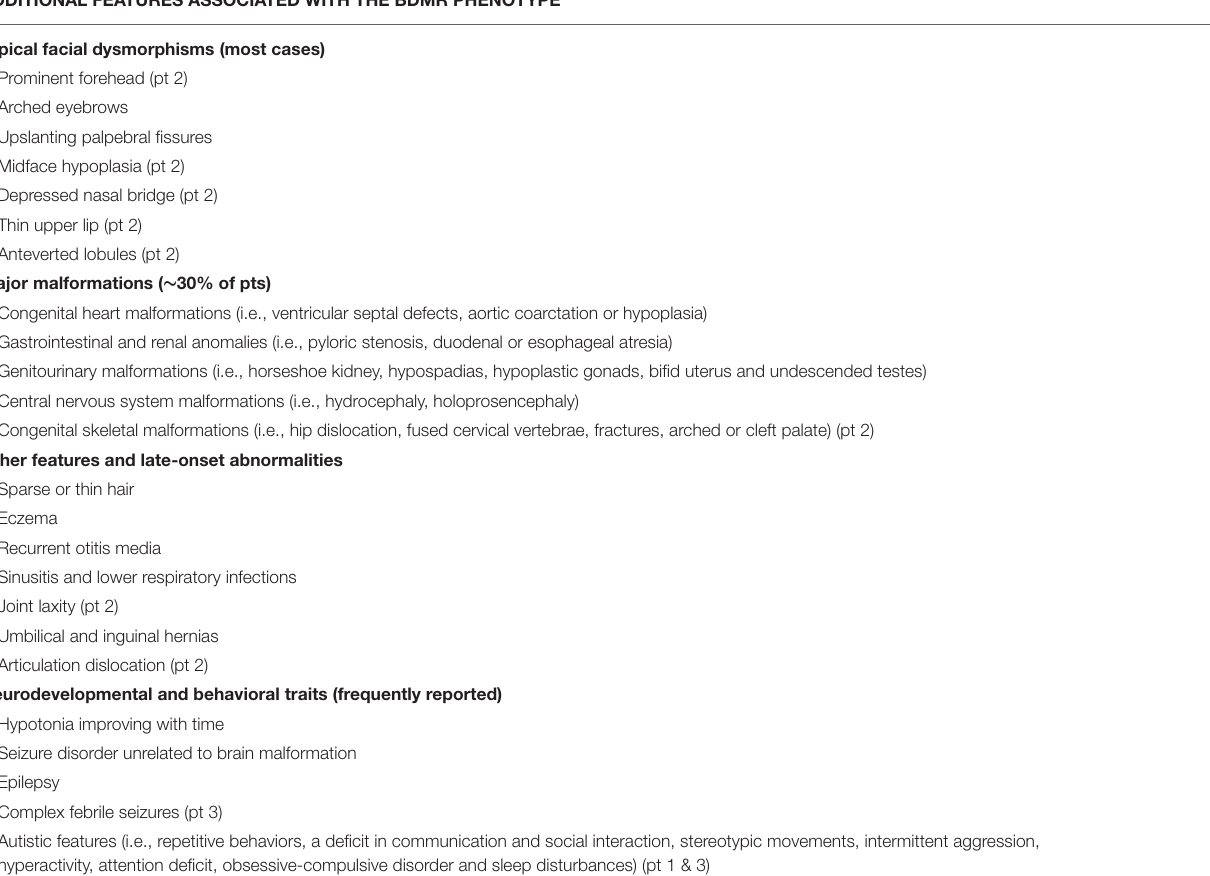
TABLE 2 | Table summarizing features associated with the BDMR